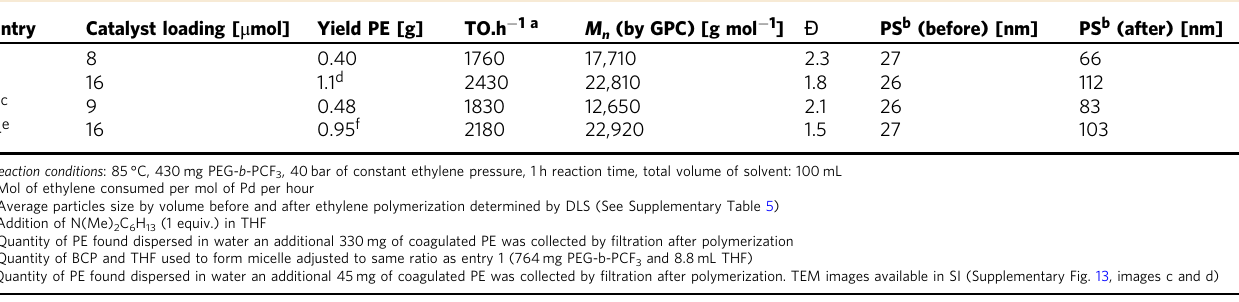
Table 5 L 2 Pd-DMSO catalyzed polymerizations of